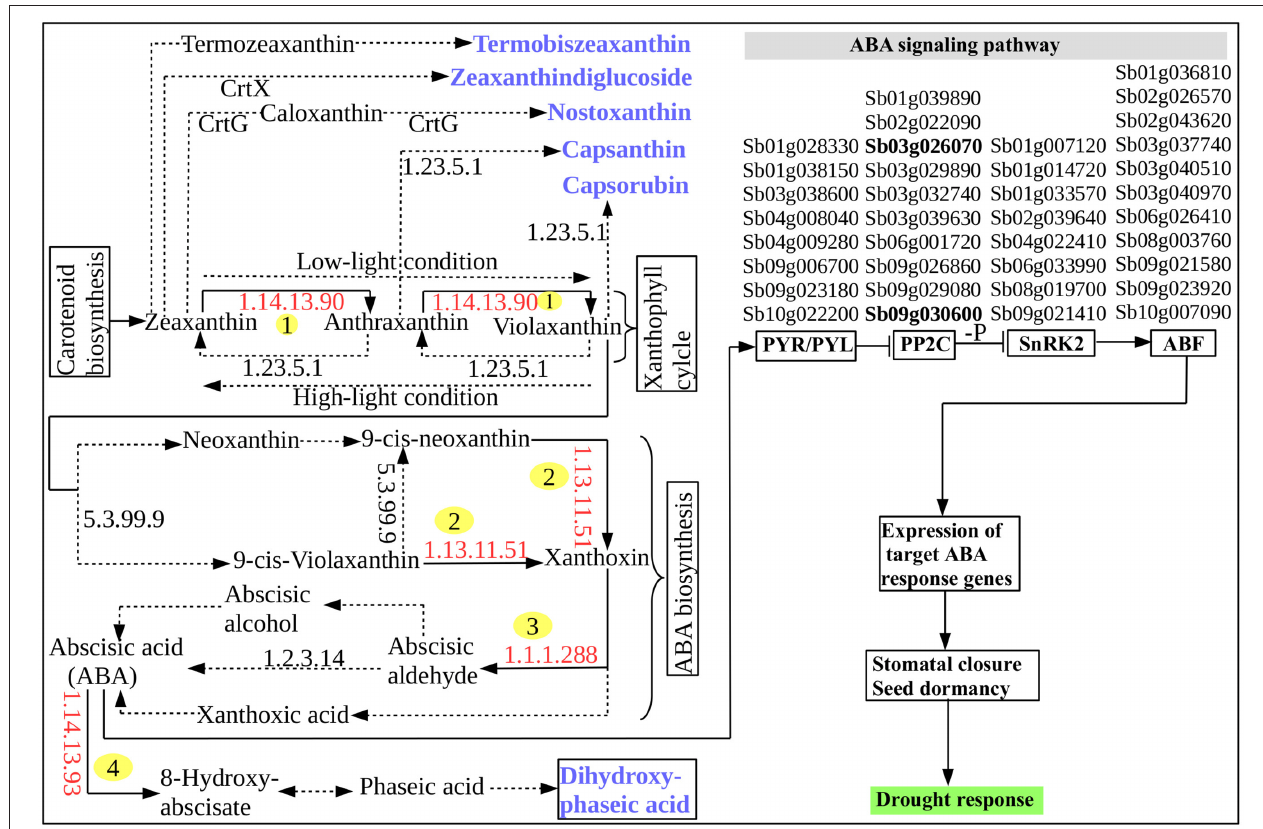
FIGURE 3 | ABA biosynthesis and signaling pathway. The identified enzymes encoded by the S. bicolor tissues are indicated by the red enzyme numbers (EC-number) and are labeled with numbers in yellow circle while all other enzymes are indicated by the black EC-numbers and are not labeled. The chemical reaction catalyzed by the enzymes encoded by the S. bicolor tissues and that were identified in this study are indicated by black solid arrows. All other reactions and intermediates are indicated with black dashed/dotted arrows. End products are indicated by blue color and bold. A four-column list of ABA or drought-inducible genes that are involved in the ABA signaling occur in the signaling pathway in such a way that each column of the list corresponds from the left to the right to the protein–protein interaction relay channels: PYR/PYL, PP2C, SnRK2, and AREB/ABF for regulating the ion channels and initiating stomatal closure. The 2 highlighted PP2C family genes, “Sb03g026070” and “Sb09g030600,” among others, share, a wide array of functional features with other genes that involve in the cross-talk between ABA biosynthesis and signaling pathway and drought-inducible regulatory network ( Table S1